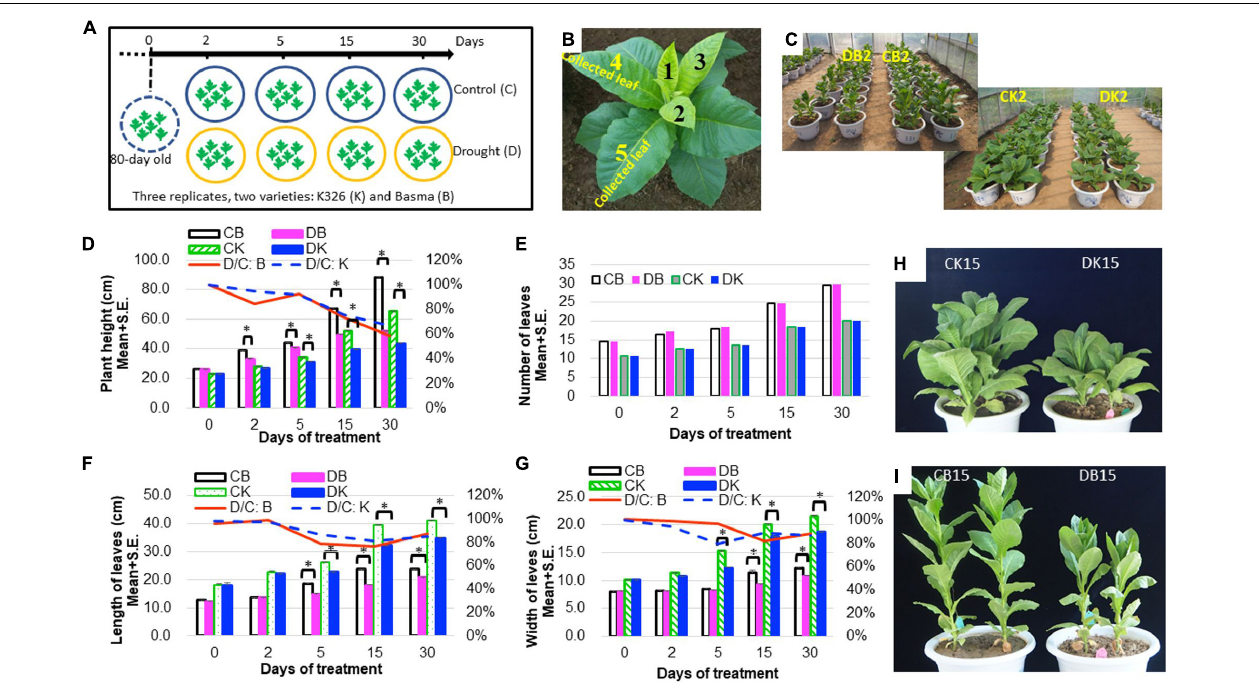
FIGURE 1 | Phenotypic changes of N. tabacum varieties K326 and Basma under drought treatment. (A) The experimental scheme of treatments and sampling time. (B) The fourth and fifth leaves at 80-day old which were tagged and then collected in each time course. (C) Plants after 2 days of treatment. (D) Changes of the plant height. (E) Changes of the total number of leaves. (F) Changes of the leaf length. (G) Changes of the leaf width. (H) K326 plants after 15 days of treatment. (I) Basma plants after 15 days of treatment; * for statistical significance at p < 0.05. SE, for standard error. CB, DB, CK, DK, D/C:K, and D/C:B represent control B, drought treated B, control K326, drought treated K326, percent of drought to control at the same time point in K326, and percent of drought to control at the same time point in BX, respectively. For all examinations, three experimental replicates with six biological plants in each replicate were